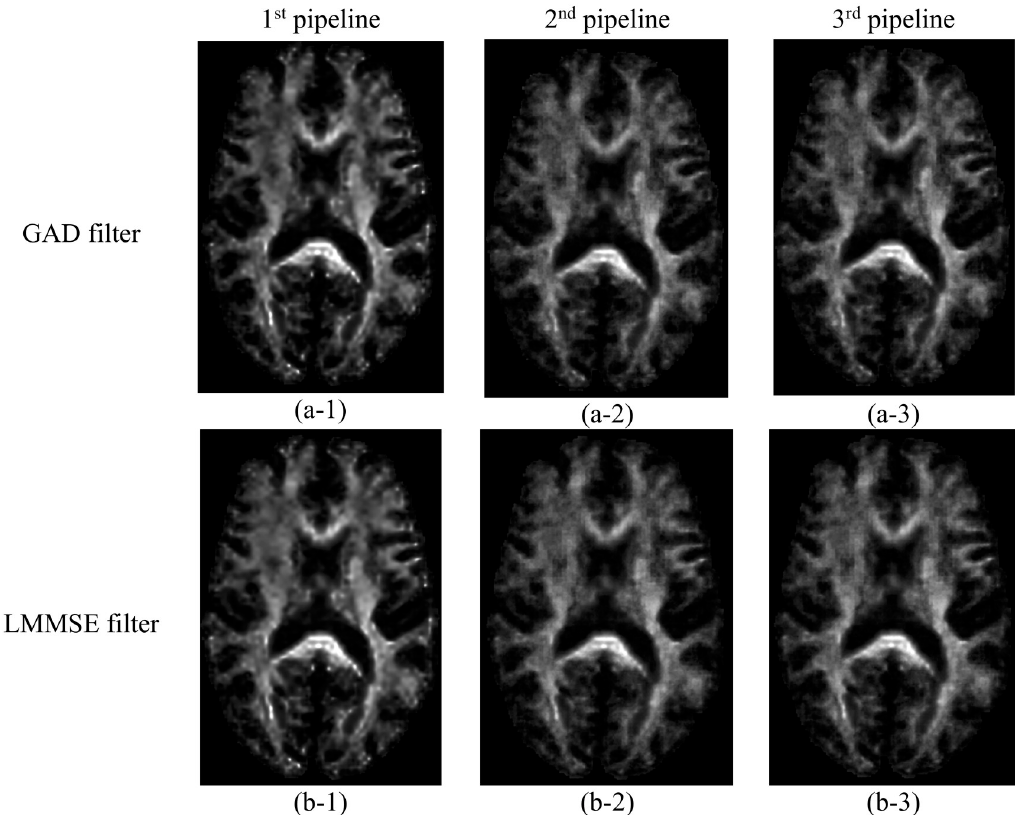
Fig 12. FA maps for the dataset LM-20 obtained by different pipelines when using the gradient anisotropic diffusion (GAD) filter (first row) and Rician linear minimum mean square error (LMMSE) filter (second row). First, second, and third columns correspond to the 1 st , 2 nd , and 3 rd DTI processing pipeline, respectively. The images were not